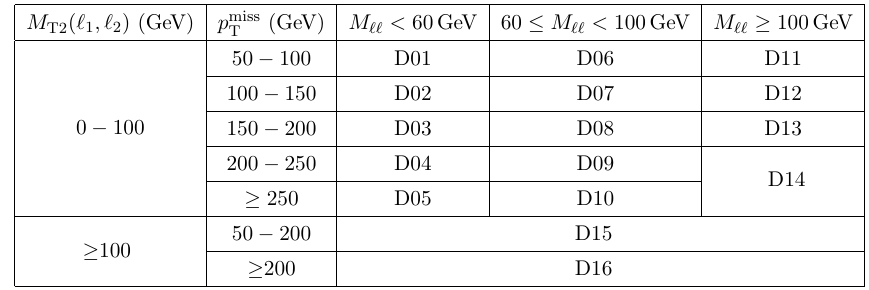
Table 5 . Search region de(cid:12)nition corresponding to category D, events with one e and one (cid:22) of OS and one (cid:28) h candidate.